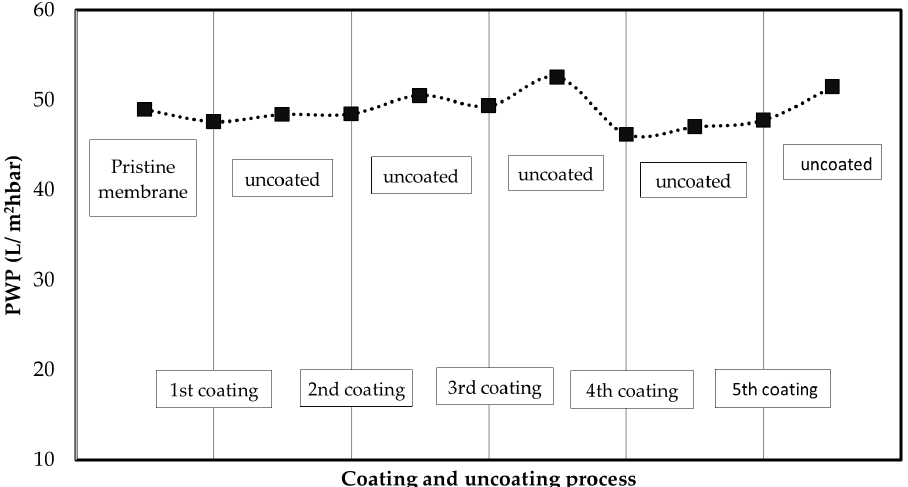
Figure 8. Membrane performance in terms of PWP during coating with 6.5 g/m 2 of CNFs and coating removal cycle.